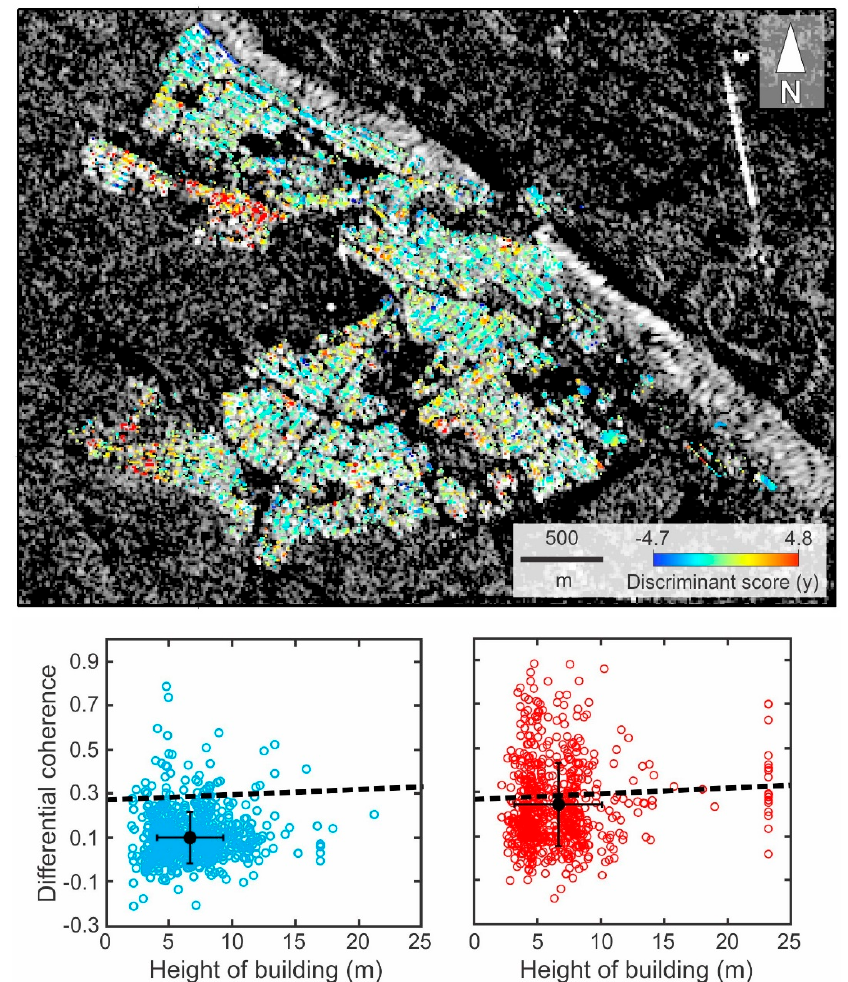
Figure 7. Damage proxy map of Sarpole-Zahab from logistic discriminant analysis with scatter plots of the uncollapsed (blue circles) and collapsed (red circles) buildings. The mean values and standard deviations of both categories are shown with solid black circles and black error bars, respectively. The thick dashed lines are the threshold bars inferred from the discriminant analysis.